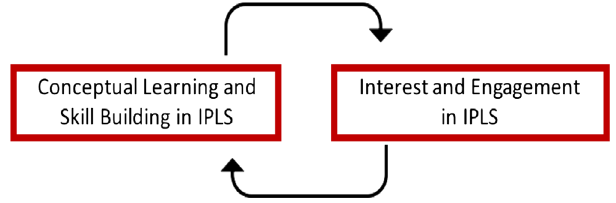
FIG. 1. Interest and engagement can enhance students ’ atten- tion, effort, and conceptual learning (bottom arrow). At the same time, positive affective experiences stemming from particular aspects of the IPLS curriculum can be ends in and of themselves (top